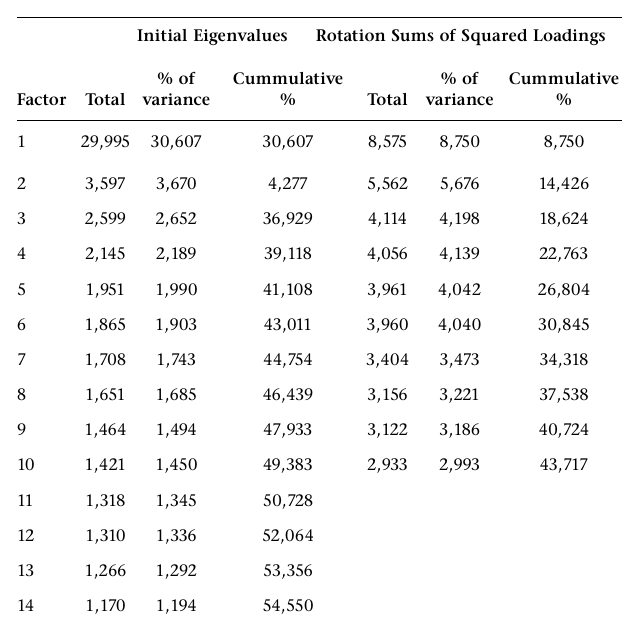
TOTAL VARIANCE EXPLAINED